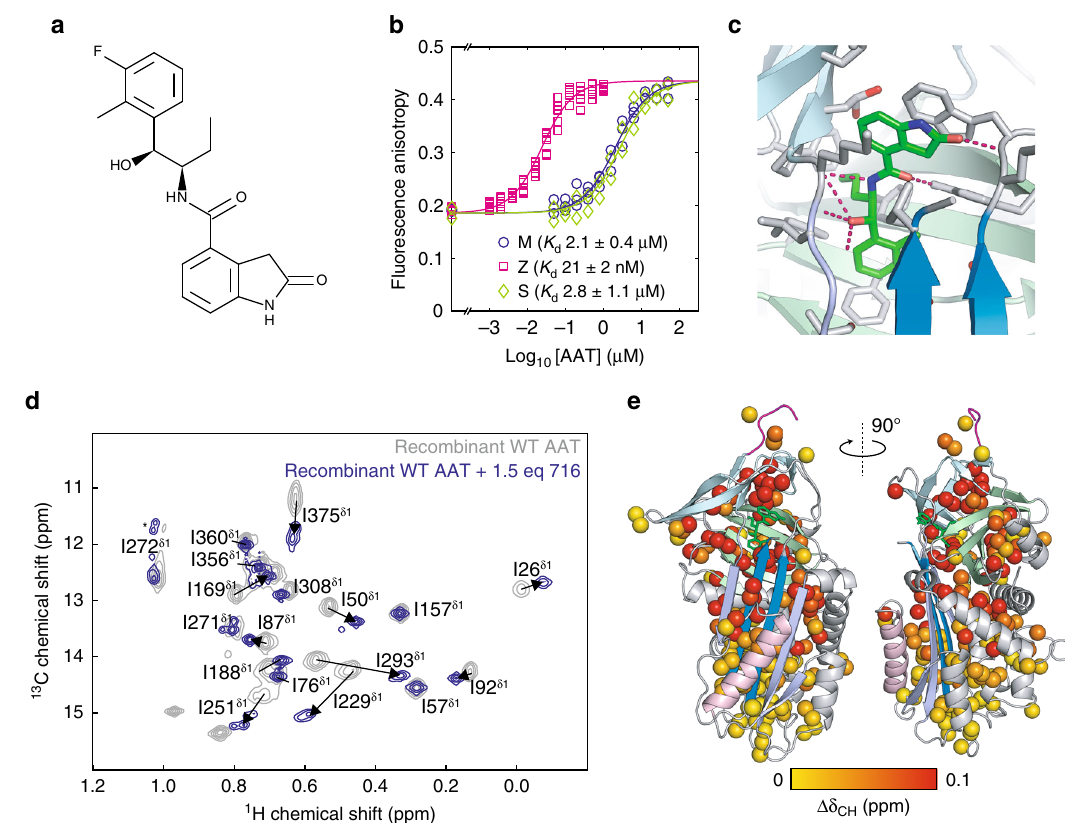
Fig. 6 Binding of the small-molecule polymerisation inhibitor 716 to AAT. a Chemical structure of the inhibitor 716 50 . b Measurement of the binding af fi nity of Alexa-488-labelled 716 for M, Z and S AAT using a fl uorescence polarisation assay 50 . c Crystal structure (PDB ID: 7AEL) illustrating the binding site of 716 50 . d Assigned 1 H, 13 C HMQC spectra (isoleucine region) of [ 2 H, A β I δ 1 L δ 2 V γ 2 M ε - 13 CH 3 ]-labelled recombinant wild-type AAT in the presence and absence of an excess of 716. Asterisks indicate minor peaks arising from sample degradation. e Combined methyl chemical shift changes in recombinant q ffiffiffiffiffiffiffiffiffiffiffiffiffiffiffiffiffiffiffiffiffiffiffiffiffiffiffiffiffiffiffiffiffiffi (cid:3) (cid:4) 2 Δ δ 2 þ Δ δ = 4 , projected on the structure of 716-bound AAT 50 . The bound 716 ligand is indicated in green. Colouring AAT upon 716 binding, Δ δ CH ¼ C H of secondary structure elements is consistent with Fig. 1b. Source data are provided as a Source Data fi